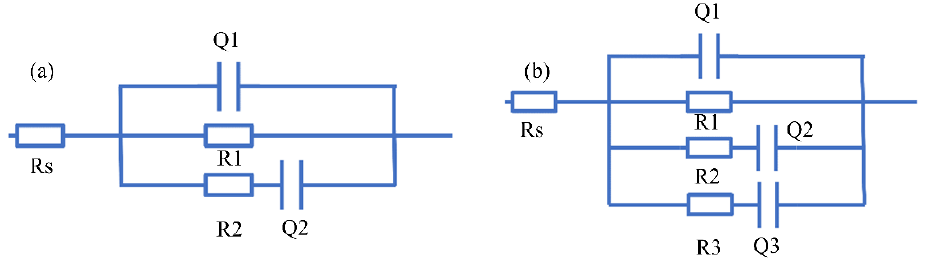
Figure 8. Corrosion test of Ta substrate, TD film and TTTD film in weak alkaline environment: ( a ) Nyquist curve, ( b ) polarization curve, ( c ) phase angle diagram, ( d ) impedance value. Table 1. Corrosion current density and corrosion potential of substrate, TD and TTTD films in weak alkali environment.